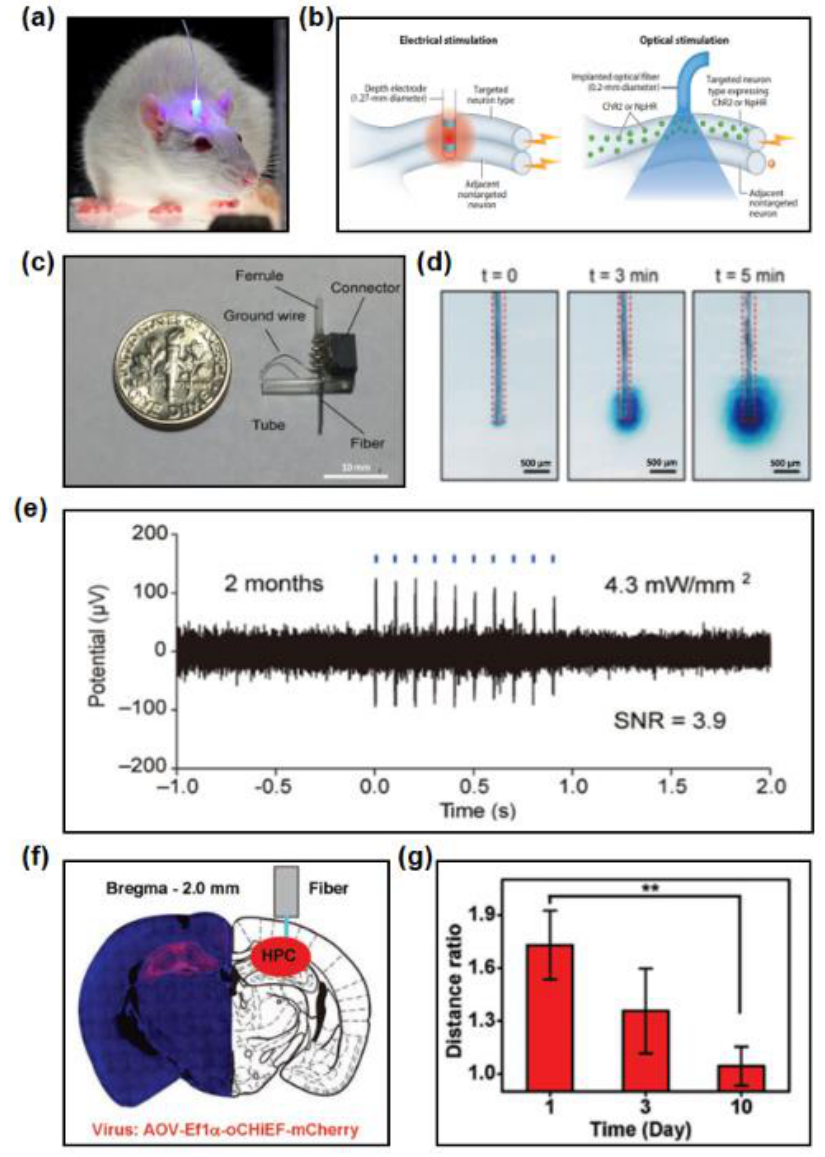
Figure 8. Application in optogenetics. ( a ) A fiber implanted into a freely behaving mouse. Reproduced with permission [76]. Copyright 2015. ( b ) Comparison of electrical simulation ( left ) and optical stimulation ( right ) for neural cells. Reproduced with permission [20]. Copyright 2014,